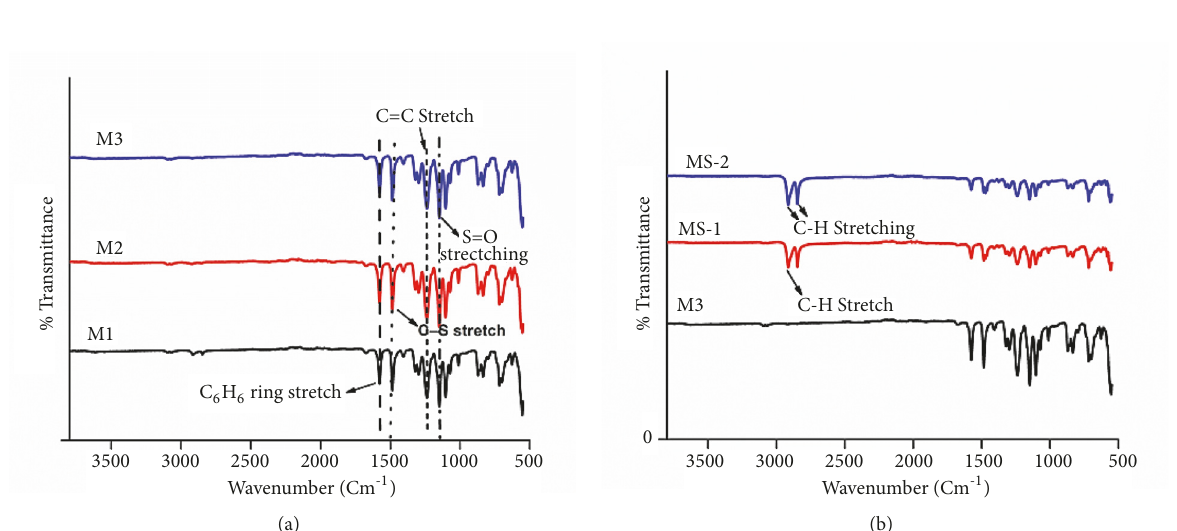
Figure 2: ATR-FTIR spectra of membranes prepared by (a) polymer concentration variation and (b) membranes prepared by solvent variation.